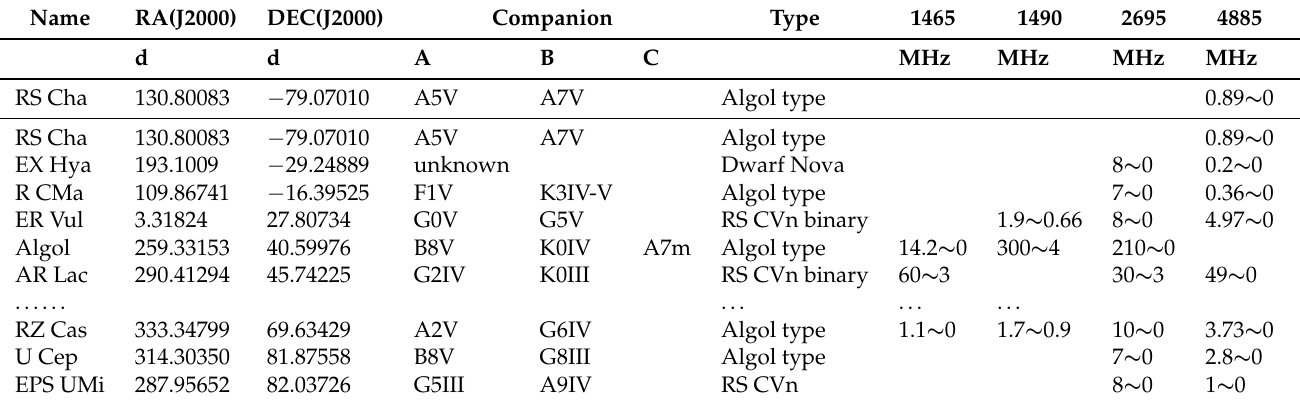
Table 1. Parameter of radio eclipsing binaries [6,7].